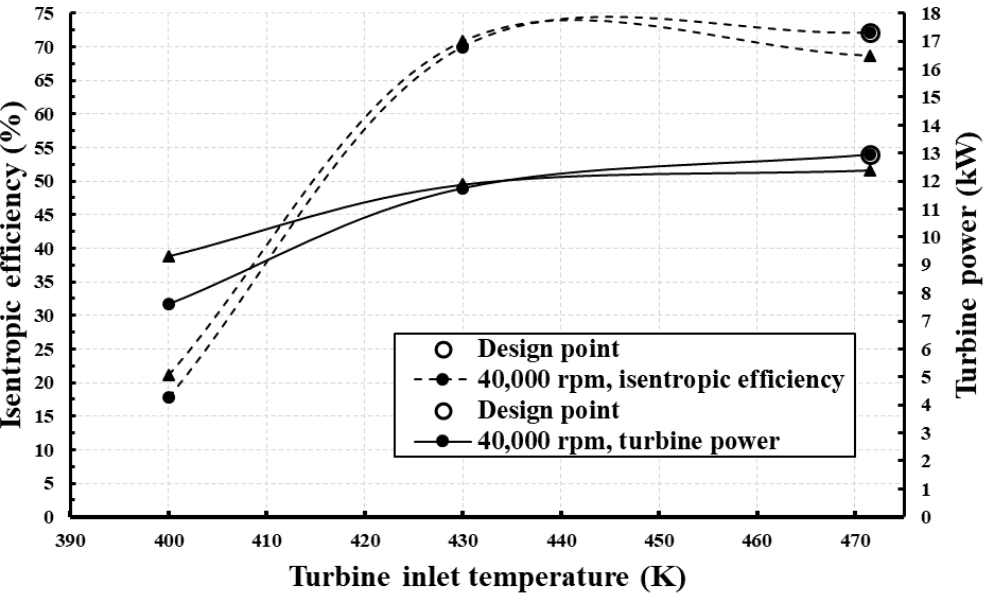
Figure 25. Turbine efficiency and power output at various turbine inlet temperatures.